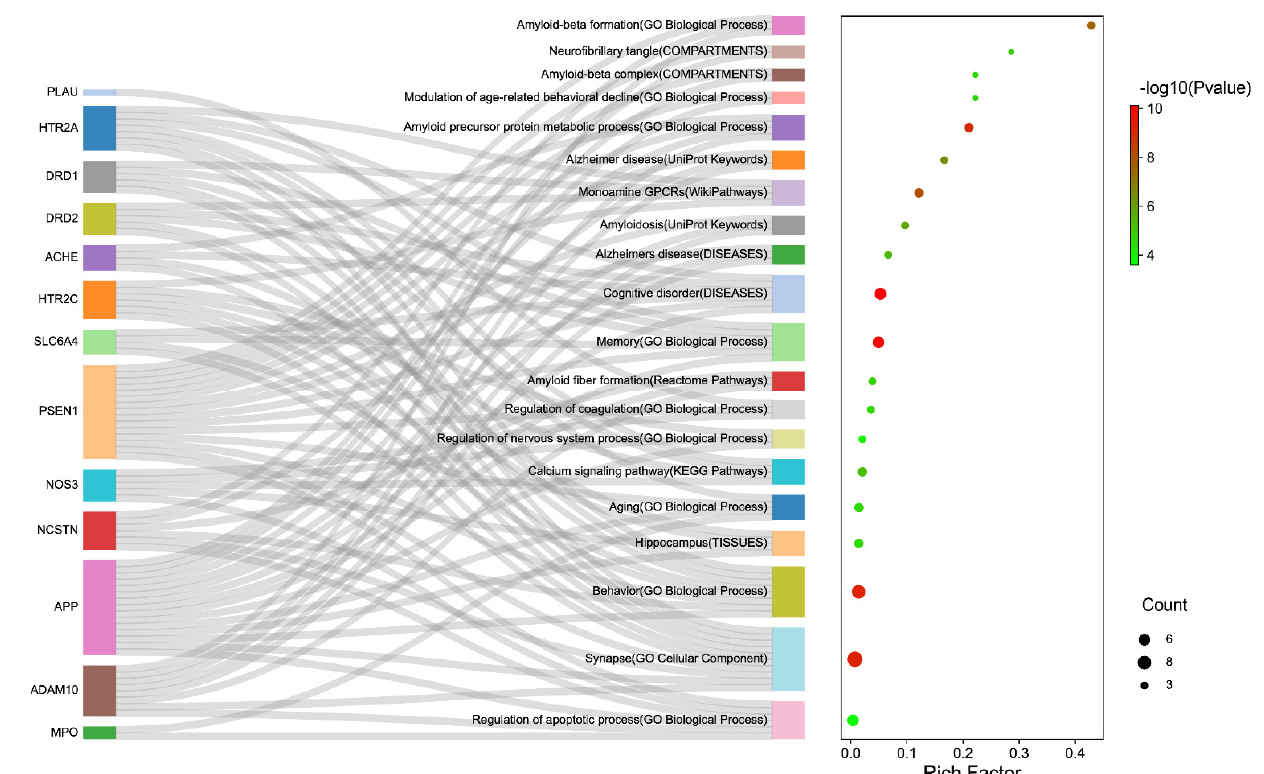
Figure 3. The multi-dimensional enrichment analysis based on validated targets, including Gene Ontology, KEGG Pathways, Reactome Pathways, WikiPathways, Tissue expression (TISSUES), Sub- cellular localization (COMPARTMENTS), and Annotated Keywords (UniProt).